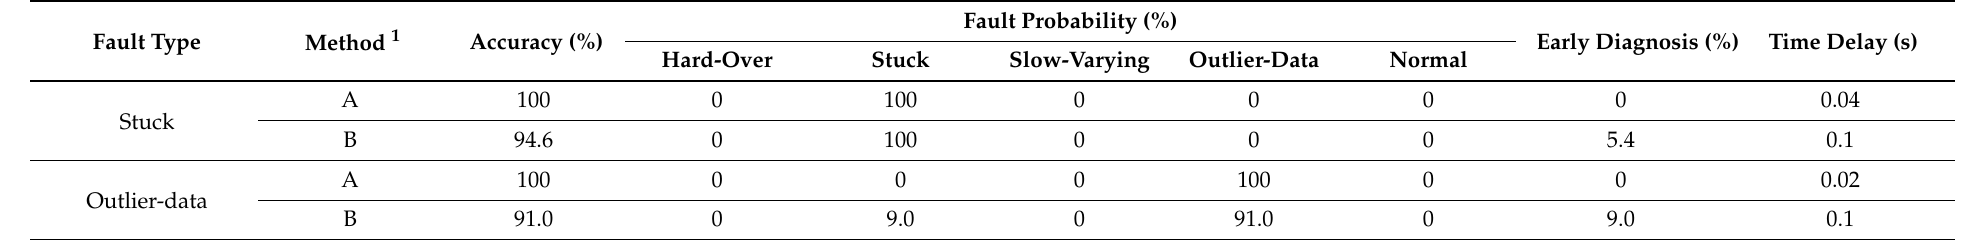
Table 7. Real-time fault diagnosis result of the stuck fault and the outlier-data